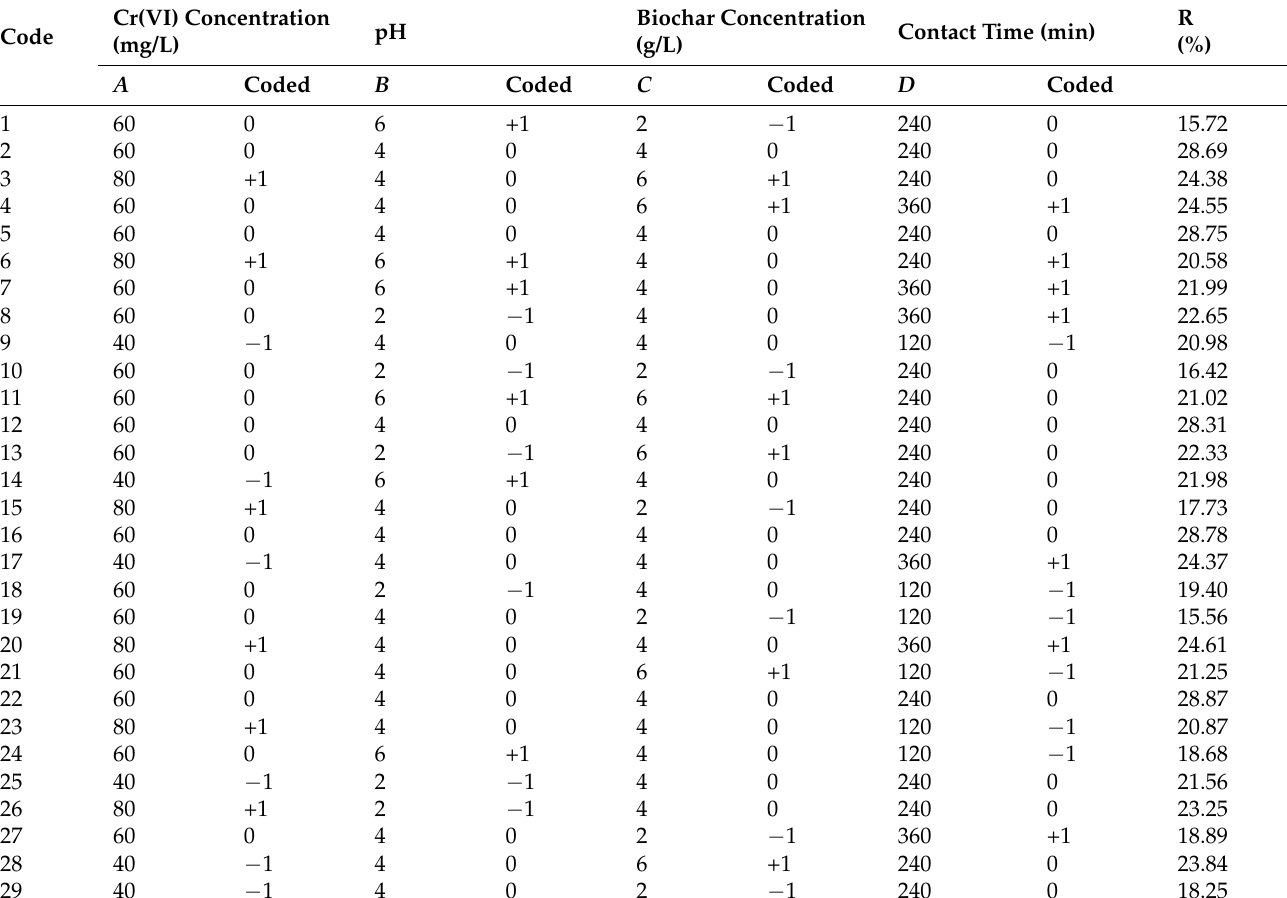
Table 2. The coded values for independent factors and the values of measured response.